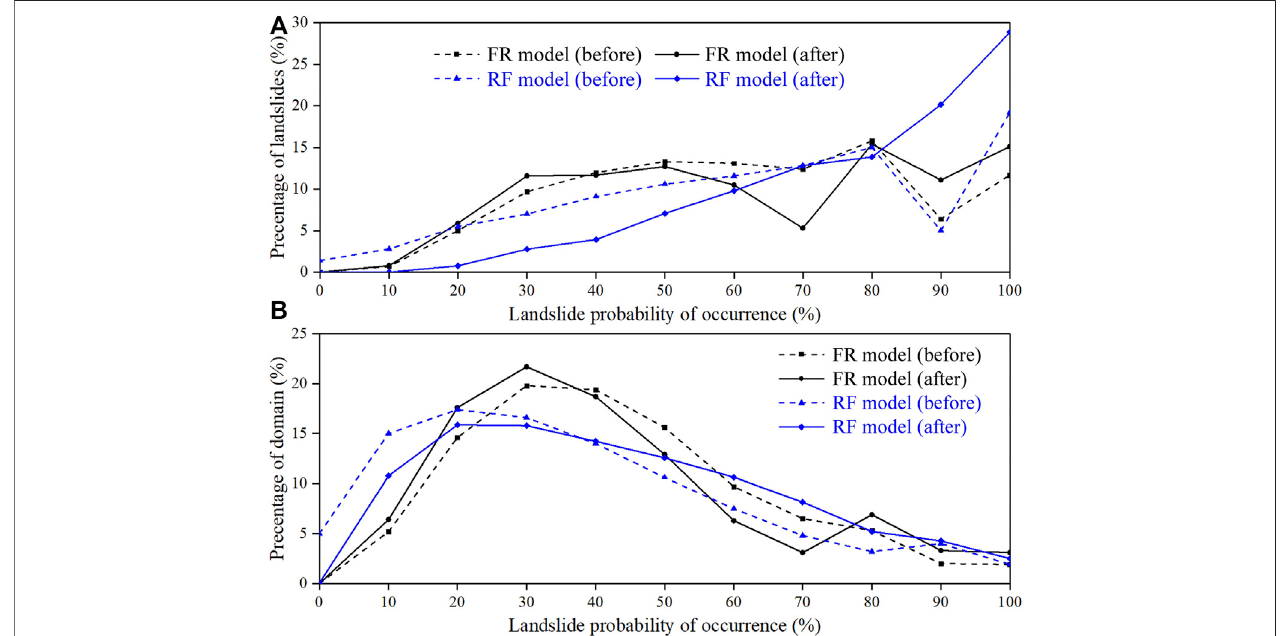
FIGURE 6 | Distribution of points versus the landslide probability of occurrence. (A) Landslide points; (B) all pixels in the domain.